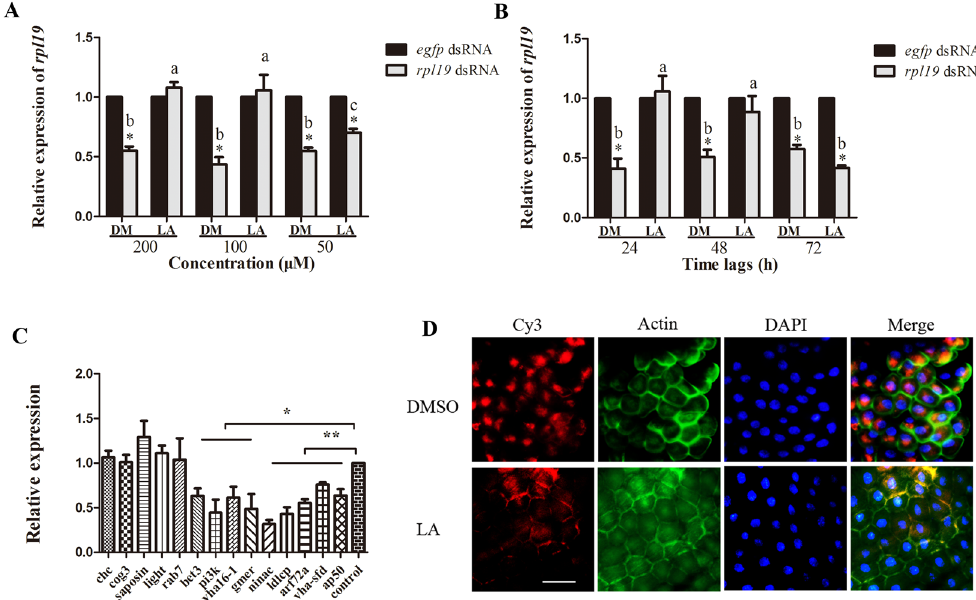
Figure 2. The blockage of RNAi caused by injecting linoleic acid. (A) mRNA accumulation of the target gene after feeding ds -rpl19 followed by injection of LA at different concentrations. (B) Feeding with dsRNA at 24 h, 48 h and 72 h after injecting LA, the mRNA accumulation of the rpl19 . (C) mRNA accumulation levels of genes known to be required for the endocytic entry of dsRNAs after injecting LA. (D) Subcellular localization of Cy3-labelled ds- rpl19 in midgut tissue after the injection of LA into B. dorsalis . The scale bar represents 25 μ m. Normalized target gene mRNA accumulation is reported relative to mRNA accumulation of the ds- egfp control, which was set to 1. All error bars represent the S.E. of the mean of three independent biological replicates. * indicates a statistically significant difference in rpl19 mRNA accumulation between the feeding ds- rpl19 group and the control ds- egfp group (P < 0.05). ** indicates P < 0.01 (Student’s t-test). Different letters indicate a significant difference in rpl19 mRNA accumulation among the feeding ds- rpl19 treatments (P < 0.05, Duncan’s